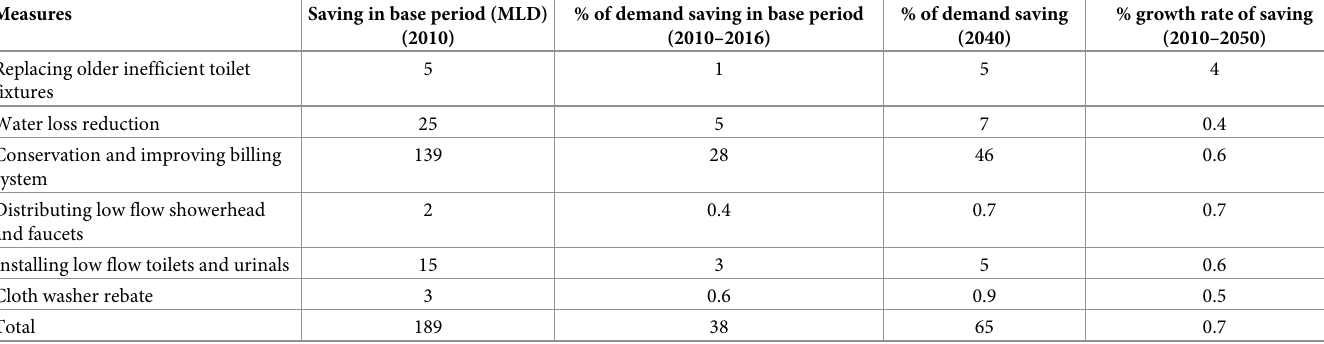
Table 2. Percent growth of water saving by conservation and demand management option [28].